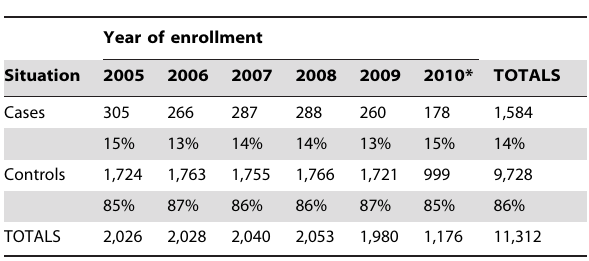
Table 1. Frequency of Tuberculosis Cases (defaulters) and Controls (cured) in the period of 2005 to 2010 – Amazonas